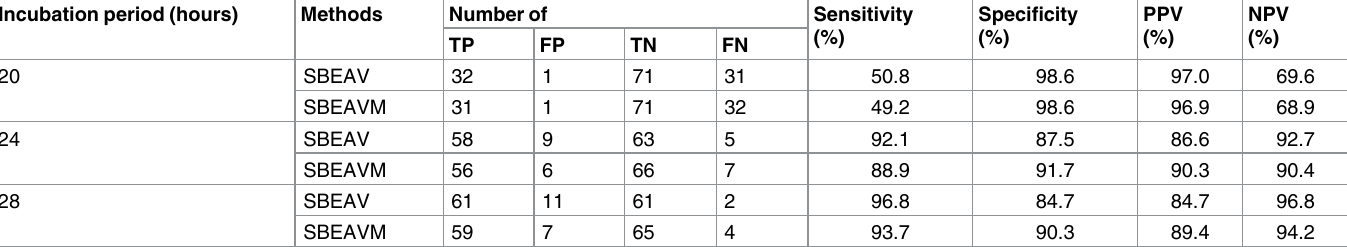
TP findings were defined as the development of gray to black color in BEAV broth (and furthered identified as E . faecium or E . faecalis by MALTI-TOF MS), and were confirmed by the ChromID VRE method FP findings were defined as the development of gray to black color in BEAV broth (and furthered identified as E . faecium or E . faecalis by MALTI-TOF MS) with negative ChromID VRE results